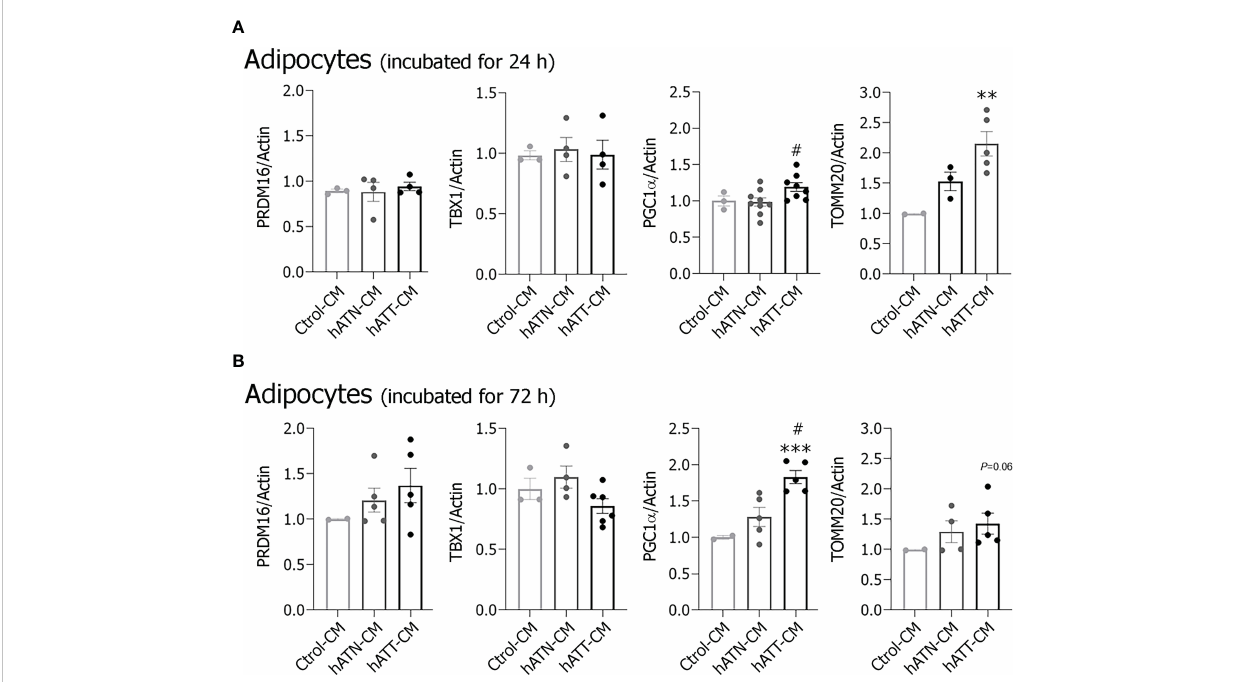
FIGURE 6 Effect of CM from hATN and hATT on the expression of beige/brown markers. 3T3-L1 adipocytes were incubated with hATN-, hATT- or Ctrol-CM for 24 and 72 h ( A, B , respectively), and then lysed. Expression of the different proteins was measured by WB. Actin was used as a loading control. Images were analyzed by densitometry. Student ’ s t-test with Welch ’ s correction was performed; **P<0.01, and ***P<0.001, adipocytes incubated with hATT-CM vs. Ctrol-CM; #P<0.05, adipocytes incubated with hATT-CM vs. hATN-CM. Ctrol-CM, control conditioned media; hATN-CM, conditioned media from human normal breast adipose tissue explants; hATT-CM, conditioned media from human breast cancer adipose tissue explants; PRDM16, proline rich domain containing 16; TBX1, TATA box 1; PGC1 a , peroxisome proliferator activated receptor g coactivator 1 a ; TOMM20, the outer mitochondrial membrane member